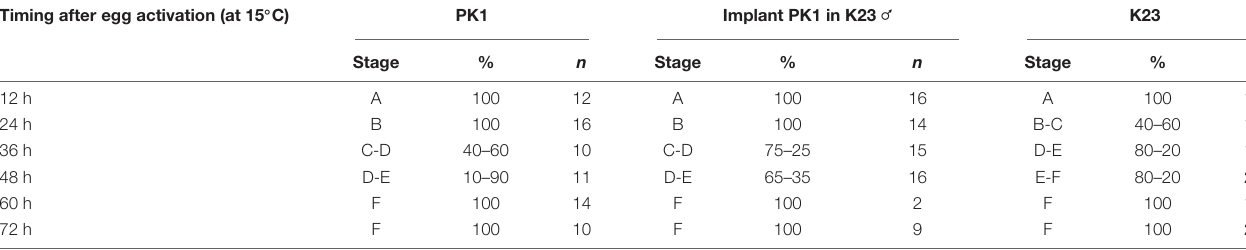
TABLE 2 | Stages of early embryogenesis in B. mori embryos incubated at 15 ◦ C. Timing after egg activation (at 15 ◦ C) PK1 Implant PK1 in K23 (cid:124)